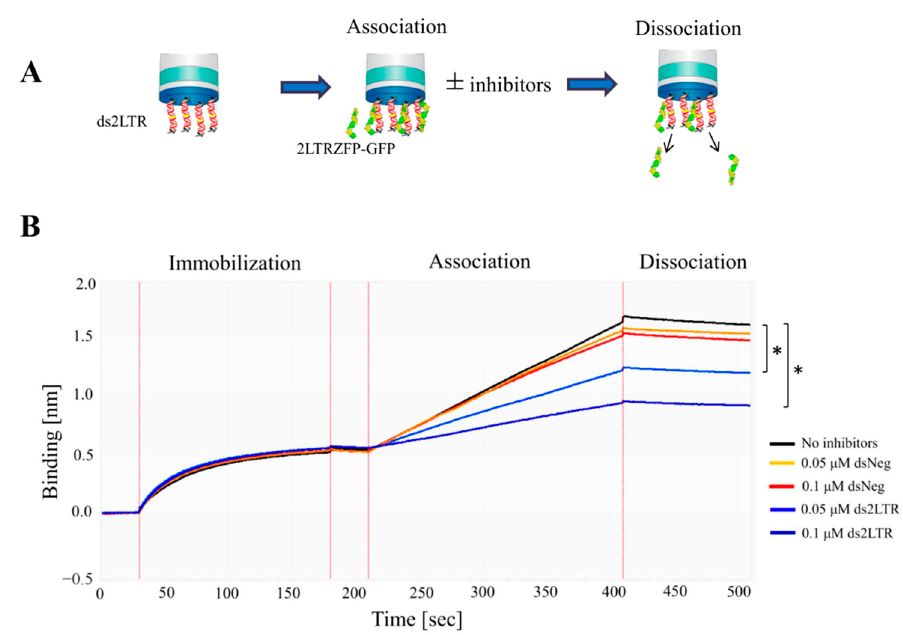
Figure 3. The binding kinetics of 2LTRZFP-GFP with its ds2LTR and dsNeg DNA target. ( A ) The schematic diagram of 2LTRZFP-GFP binding to target ds2LTR using BLItz TM system. ( B ) Representative sensorgrams displaying the kinetics of the association and dissociation of 2LTRZFP-GFP towards biotinylated ds2LTR. The biotinylated 30-bp-length ds2LTR target was immobilized on streptavidin biosensor tips. After washing step, the ds2LTR immobilized biosensor tips was then dipped into the 2LTRZFP-GFP tube with or without inhibitors and the kinetic sensorgrams were obtained using a single channel ForteBio BLItz TM instrument. Statistical significant differences of the association rate from triplicate experiments were analyzed by Student’s t -test at * p ≤ 0.05.